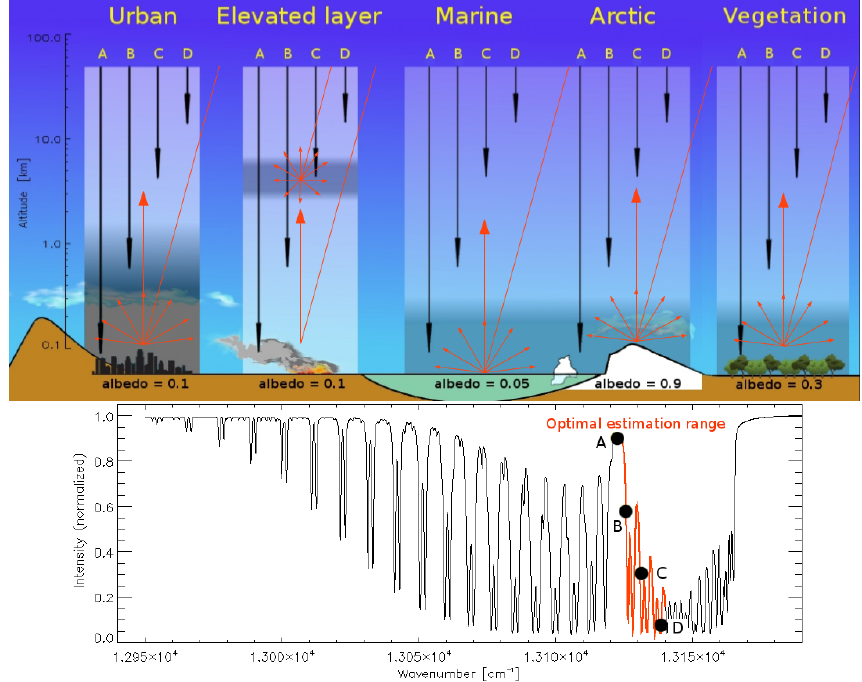
Figure 9. Example of how different instrument channels (different frequencies) probe different altitudes and thus different aerosol layers in the atmosphere. A generic channel A, sounding a spectral window of the oxygen A-band, penetrates more deeply in the atmosphere reaching the deeper levels because no absorption occurs. Moving along the shoulder of the band (channels B and C), the absorption process becomes more intense, preventing the radiation to penetrate deeper. At the bottom of the absorption band (channel D), the light is able to reach the upper part of the atmosphere only. This process is depicted in the sketch on top, where shaded gray areas represent the different aerosol profiles (arrows length is purely symbolic, not representing the actual altitude sounded at the corresponding channel). Multiple scattering of the incoming sunlight radiation (red arrows) between aerosol layers and surface at different albedo is also